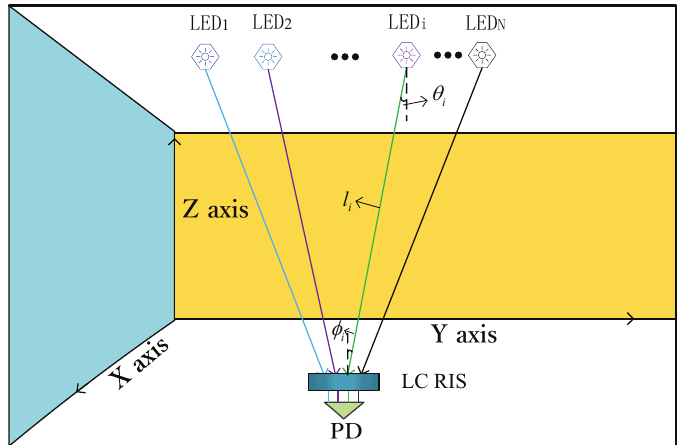
Figure 1. A MISO-VLC system with an LC RIS in the